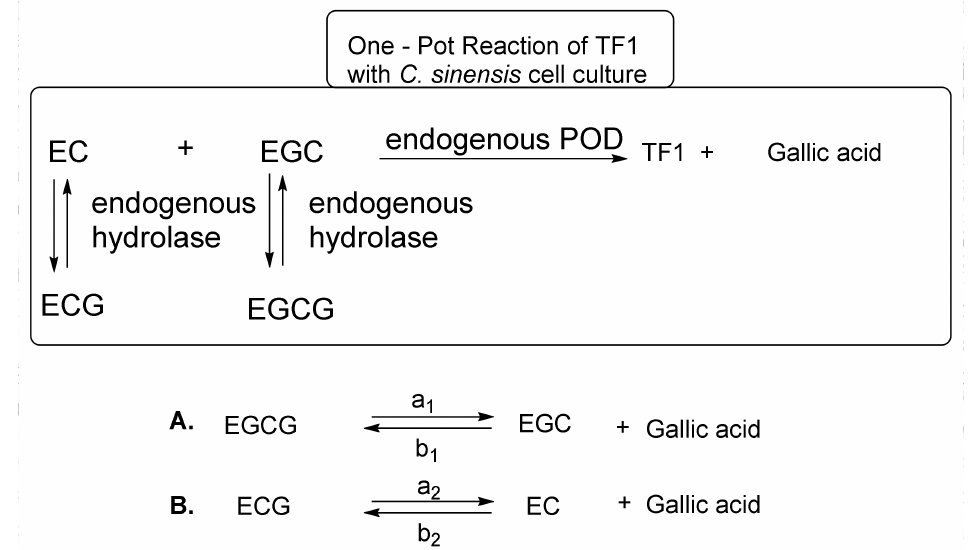
Figure 6. Equilibrium of EGCG, EGC, ECG, EC, and gallic